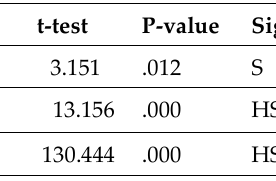
Table 5 : t-test of porosity, sensitivity and adherence test between control and optiglaze